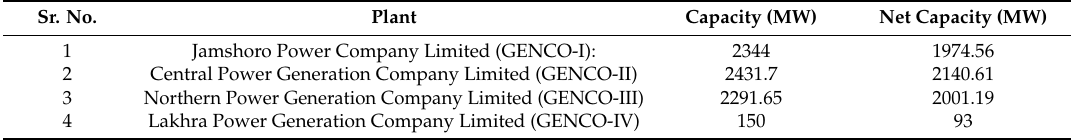
Table 8. List of thermal power plants along with their